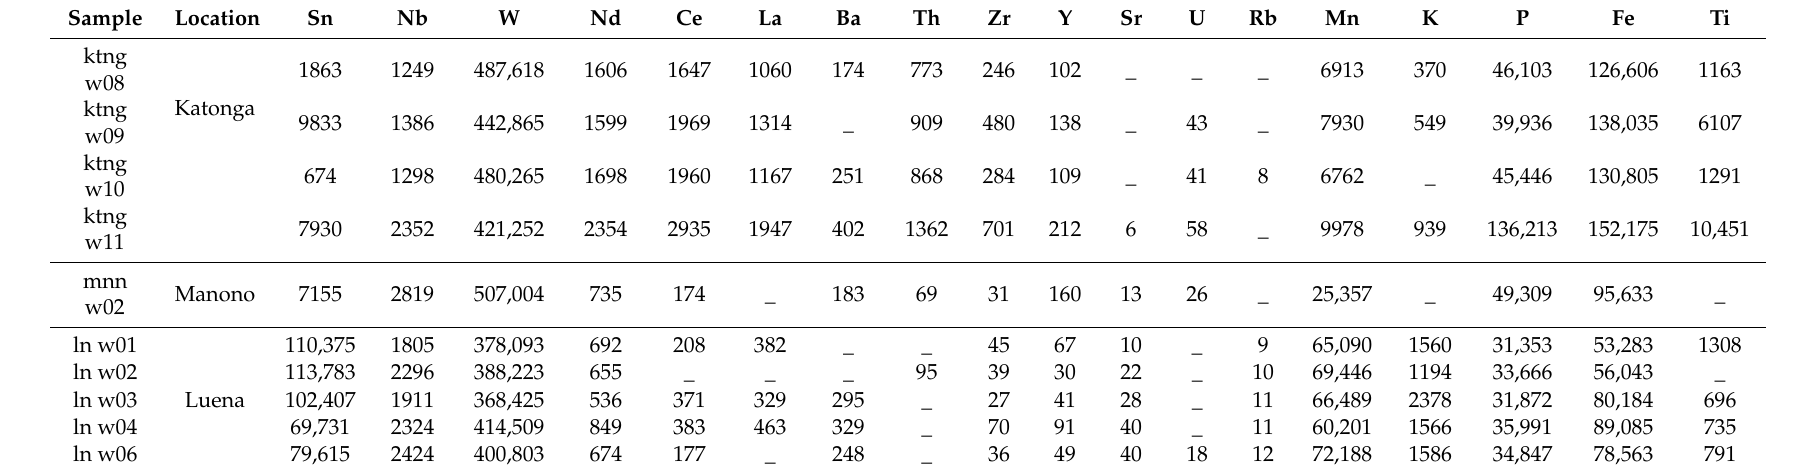
Table 5. Chemical analysis of wolframite ore samples (in ppm). Ta was not detected. —Not detected.